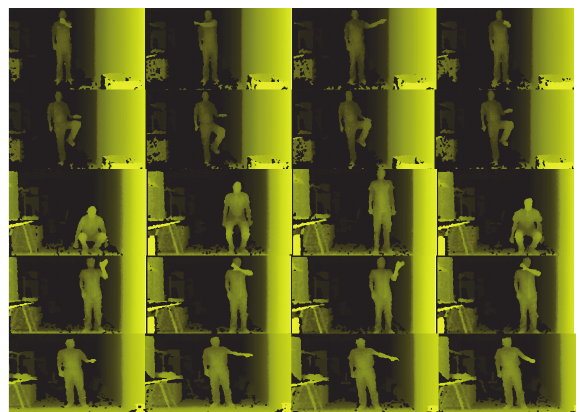
Figure 5: Screenshot images at four different positions during the four signal, leg bye signal, sit stand, wave, and point in a direction activities,